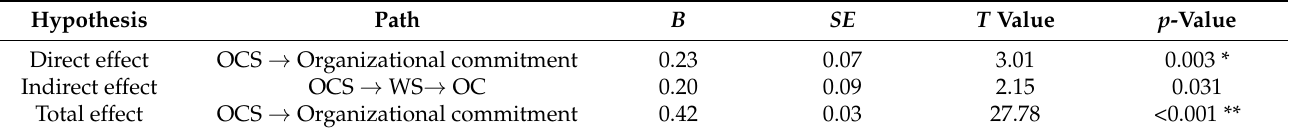
Table 5. Summary of path coefficients and hypotheses testing (mediating